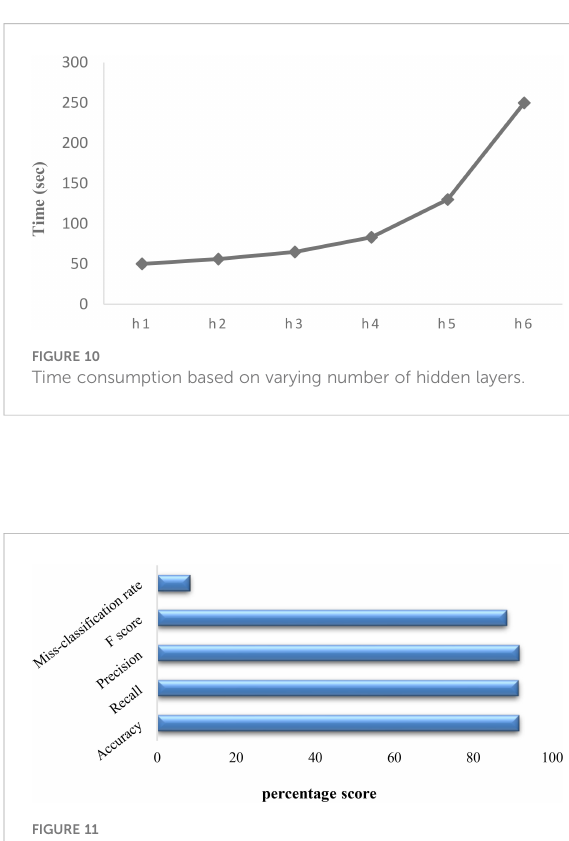
FIGURE 11 Performance